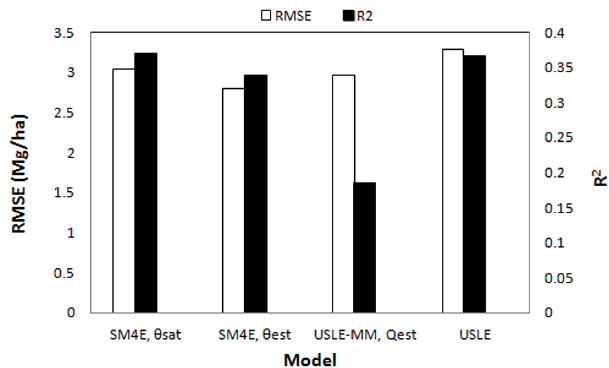
Figure 5. Comparison of the results obtained by the power SM4E model with both satellite and estimated soil moisture, the USLE- MM including predicted runoff, and the original USLE, in terms of root mean square error (RMSE) and coefficient of determination ( R 2